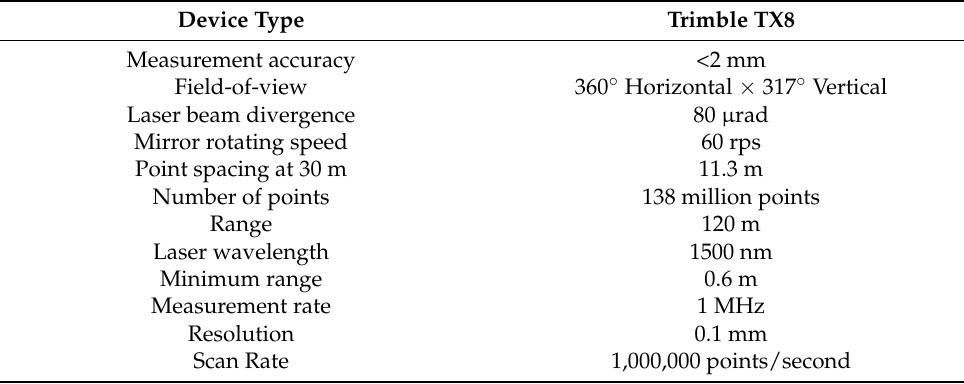
Table 1. Main technical parameters of the Trimble TX8 system.